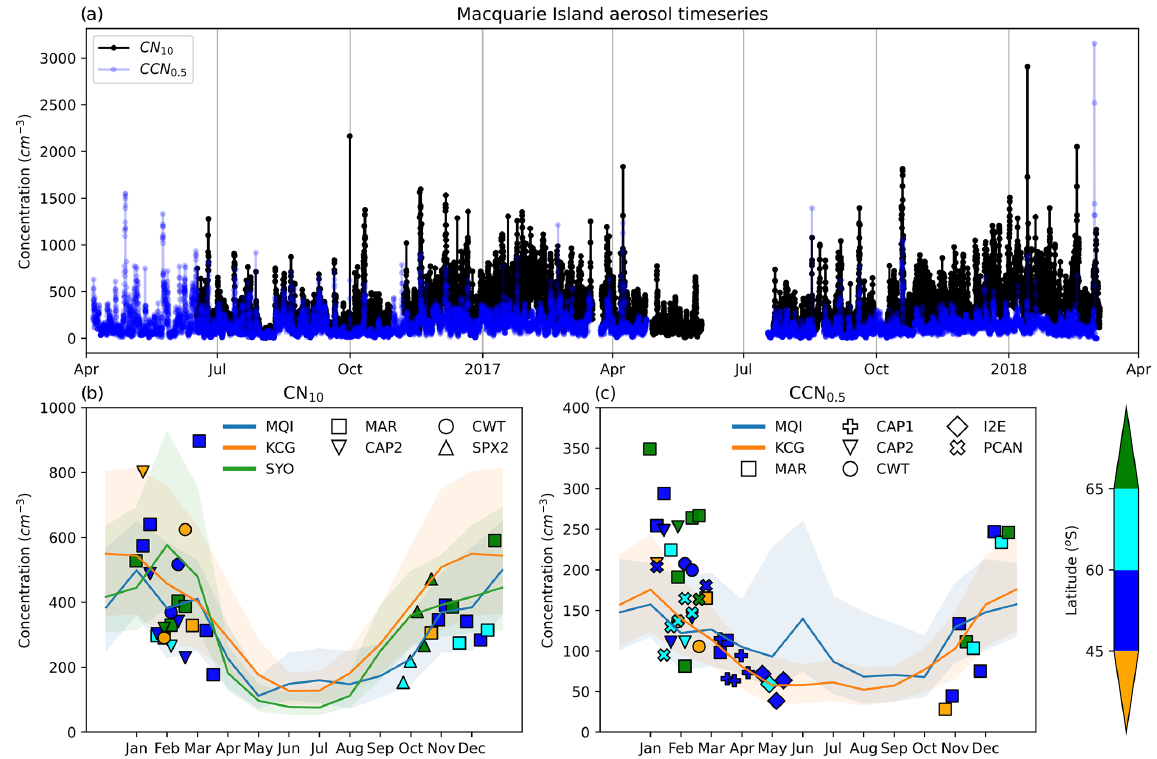
Figure 2. The full time series (a) of hourly median aerosol observations (only showing CN 10 and CCN 0 . 5 ) from Macquarie Island between April 2016 to March 2018. Seasonal cycles of CN 10 (b) and CCN 0 . 5 (c) from Macquarie Island (MQI, 2016–2018), Kennaook / Cape Grim (KCG, 2011–2020) and Syowa (SYO, 2004–2016) are shown, with monthly medians (solid line) and interquartile range (shaded regions) shown. Overlaid on the seasonal cycles are the weekly medians from ship-based campaigns coloured by latitudinal bins. Note the y scale of (c) has been adjusted to highlight the seasonal cycle, but this excludes a data point from MARCUS in March showing a weekly CCN 0 . 5 median concentration of 586cm − 3 corresponding to the CN 10 data point of 897cm − 3 in (b)